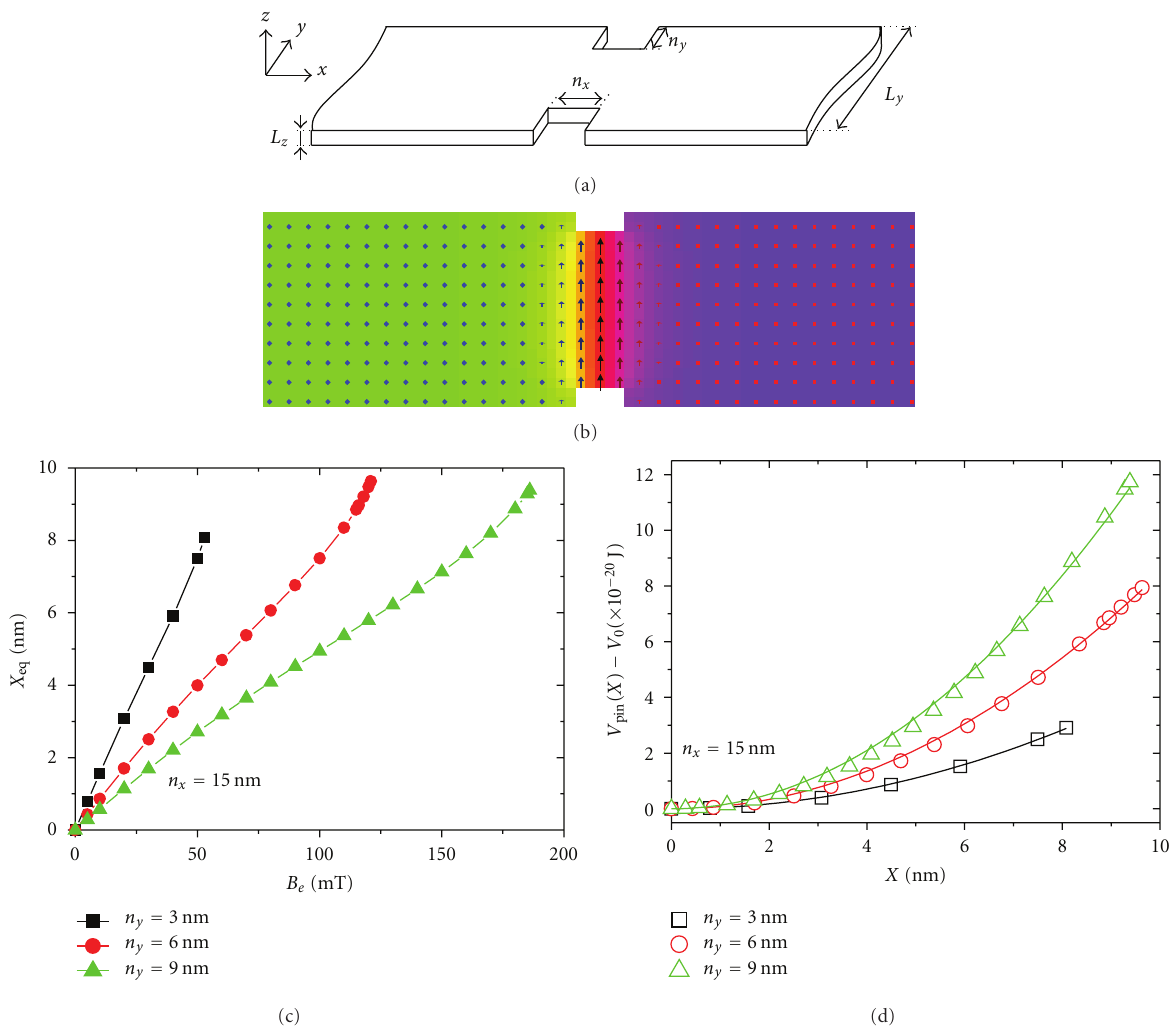
Figure 7: (a) Scheme of a pinning site consisting on two rectangular notches at both edges of the strip. (b) Equilibrium state of a pinned DW in a CoPtCr strip of L y × L z = 60nm × 3nm with a constriction described by n x = 15nm and n y = 6nm. (c) Equilibrium DW position as a function of the applied field B e in the pinned regime. (d) Pinning potential V pin as a function of the DW position. Dots correspond to micromagnetic results and the solid lines are the fittings to V pin ( X ) = (1 / 2) K N X 2 . In these last graphs the length of the notch is fixed to n x = 15nm, and three di ff erent widths are evaluated: n y :